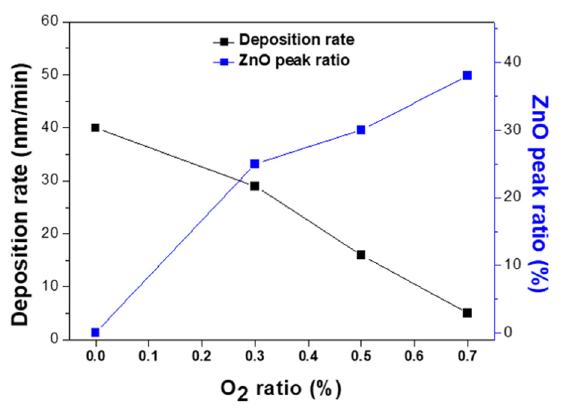
Figure 3. Deposition rates and ZnO peak ratios of the films upon variation in the O 2 ratio.